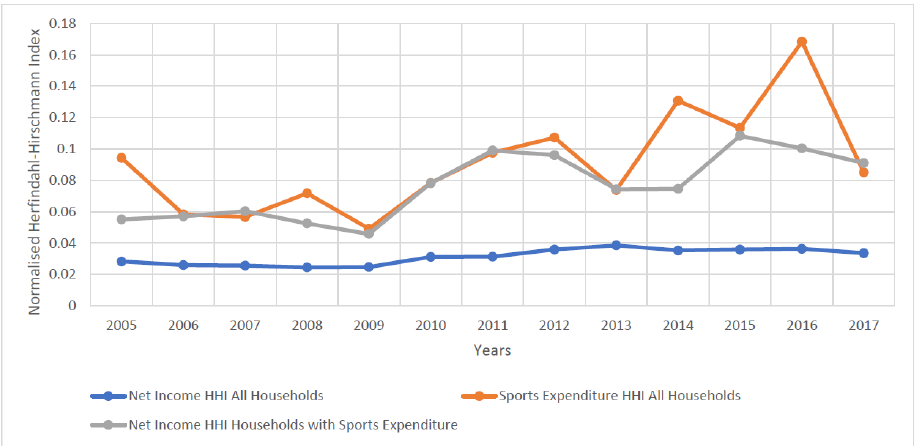
Figure A2. Herfinfahl Hirschmann Index (HHI) inequality indices in the time period 2005–2017. Source: own calculation.